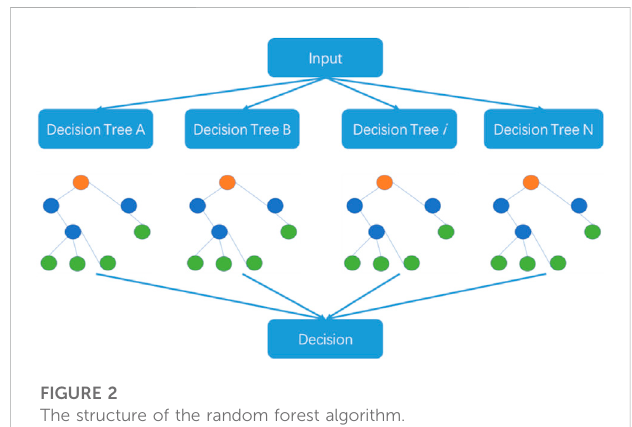
FIGURE 2 The structure of the random forest algorithm.